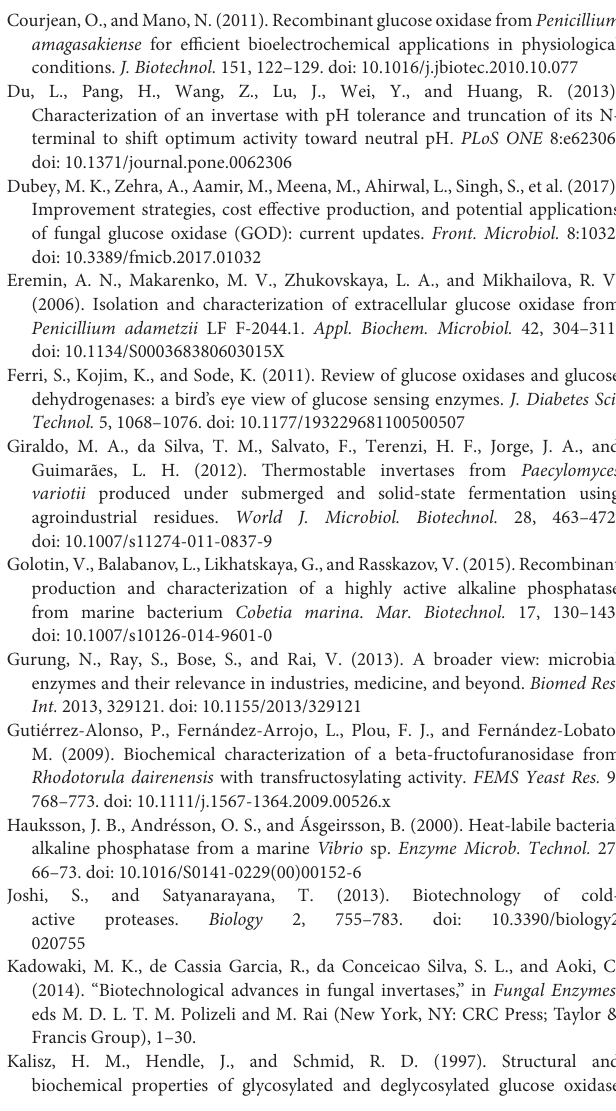
Figure S1 | Protein sample fractioning and enzyme activity determination. Total protein samples from G. gastrica (A) , W. anomalus (B) , and Dioszegia sp. (C) were fractioned by ammonium sulfate precipitation at 20% (lanes 1, 5, and 9), 40% (lanes 2, 6, and 10), 60% (lanes 3, 7, and 11) and 80% (lanes 4, 8, and 12) saturation. Each fraction was analyzed by SDS-PAGE, and the GOD (A) , Inv (B) , and ALP (C) activities were determined. At the